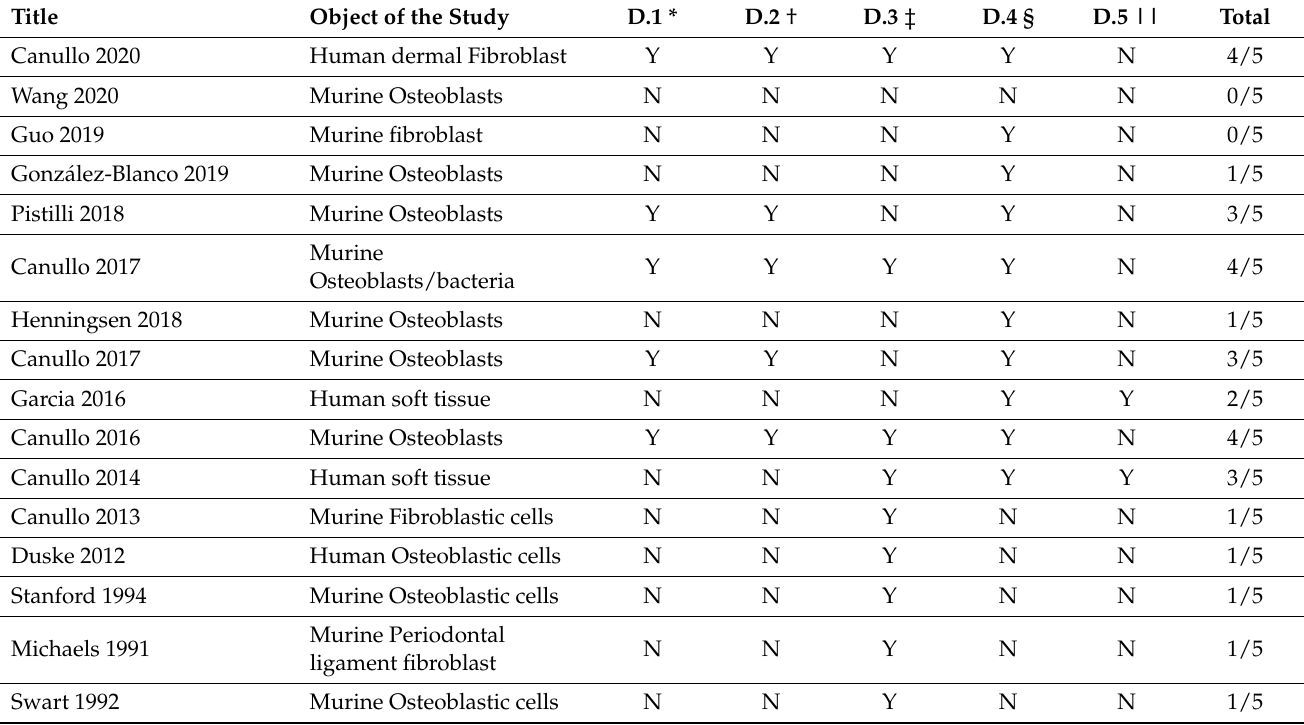
Table 2. Titles of included studies, studied cell line and CRIS